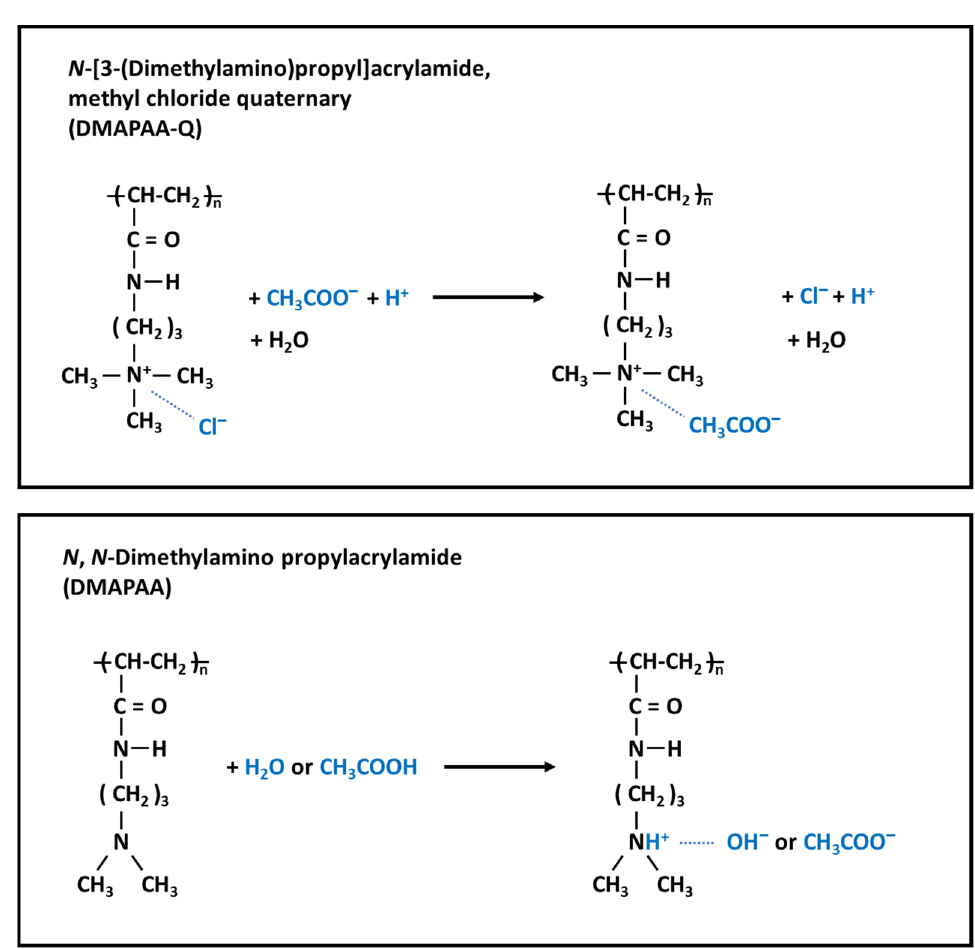
Figure 1. Chemical structures of two types of acrylamide-based polymers in the AQ11 copolymer gel. DMAPAA-Q is enriched with chloride ions (Cl – ). DMAPAA is enriched with a water molecule when acetic acid is absent. The plausible interactions are shown.